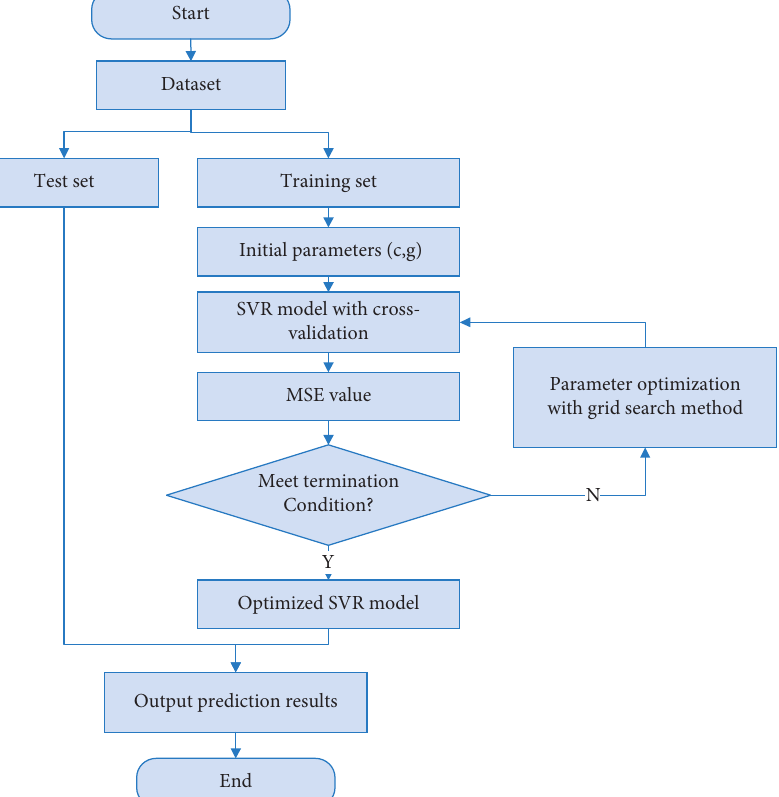
Figure 2: Flowchart of the SVR model using the GS method and